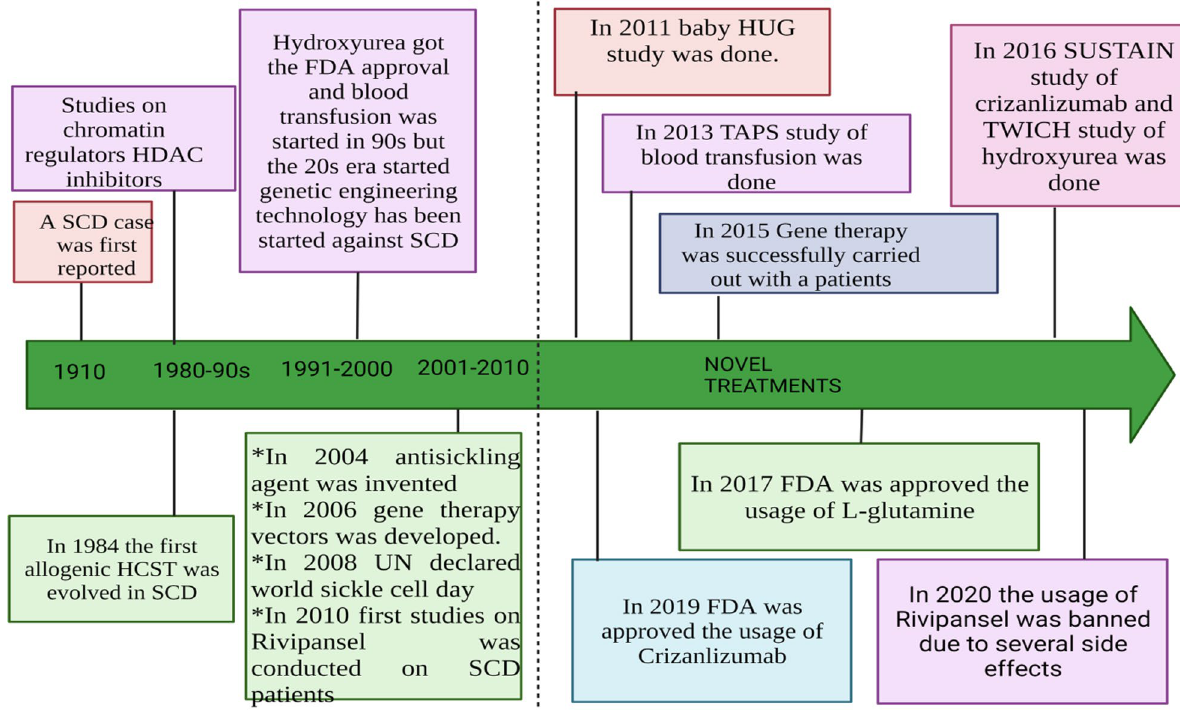
Fig. 1 A timeline representing the invention of therapeutic strategies protocols from the 90 s to now onwards (Created with